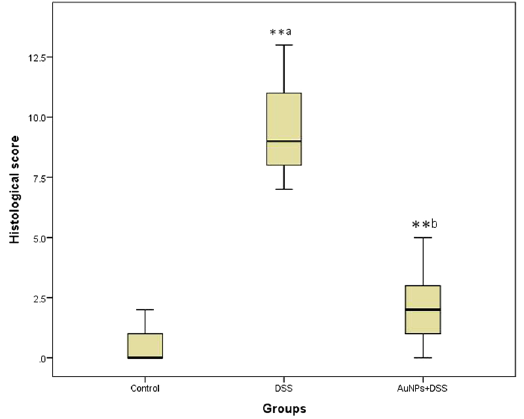
Figure 4. Histological damage scores by groups. The boxplot shows the median value (solid horizontal line), the interquartile range (box outline), and the minimum and maximum values (whiskers); a: P compared with control group; b: P compared with DSS group; ∗ : significant difference ( P < 0.05); ∗∗ : highly significant difference ( P <